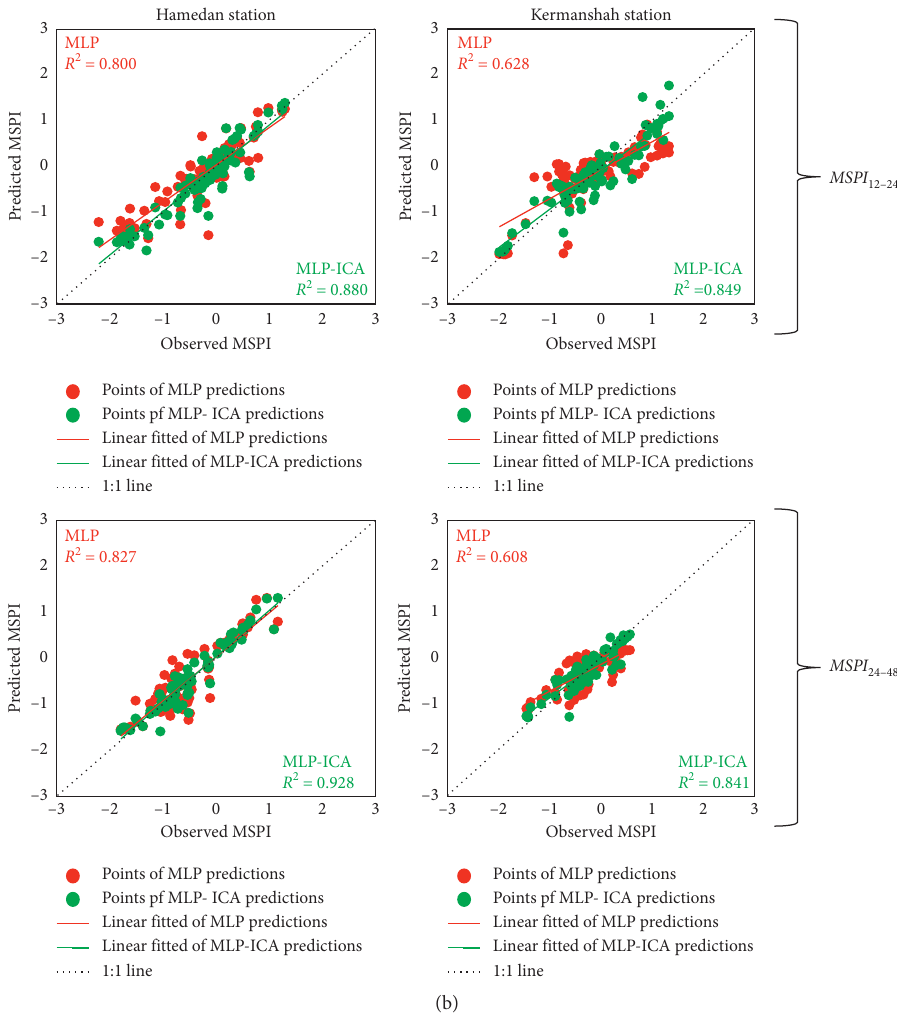
Figure 7: Scatter plots to evaluate the correlations between the models’ outputs and their observations in the test